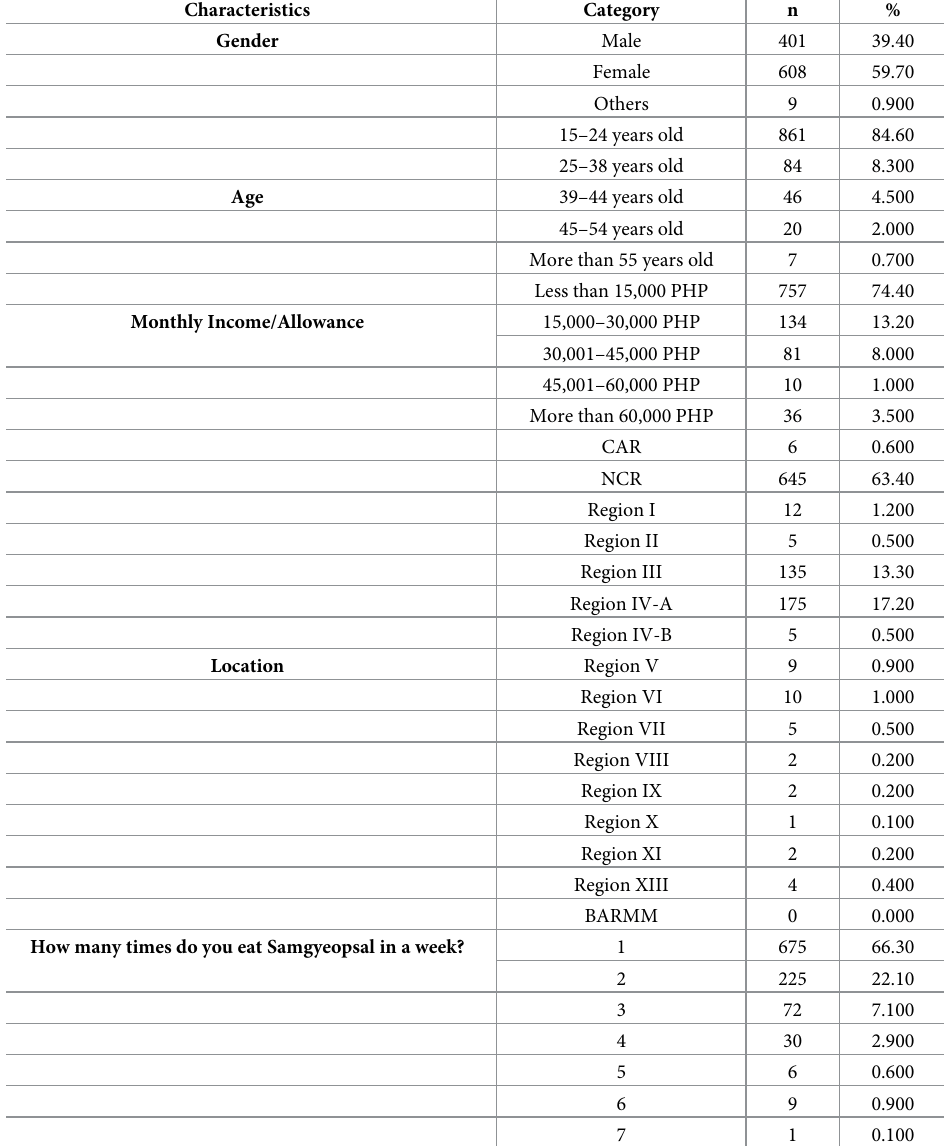
Table 3. Descriptive statistics of demographics (N: